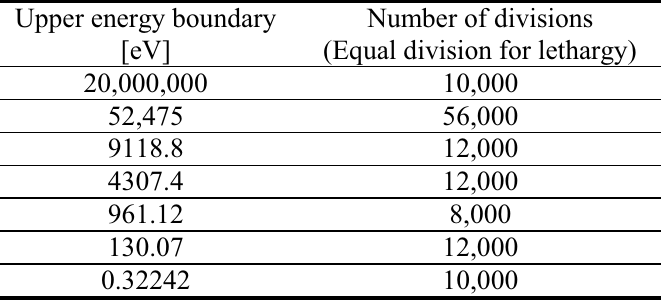
Table III. Energy group structure for ultra-fine group